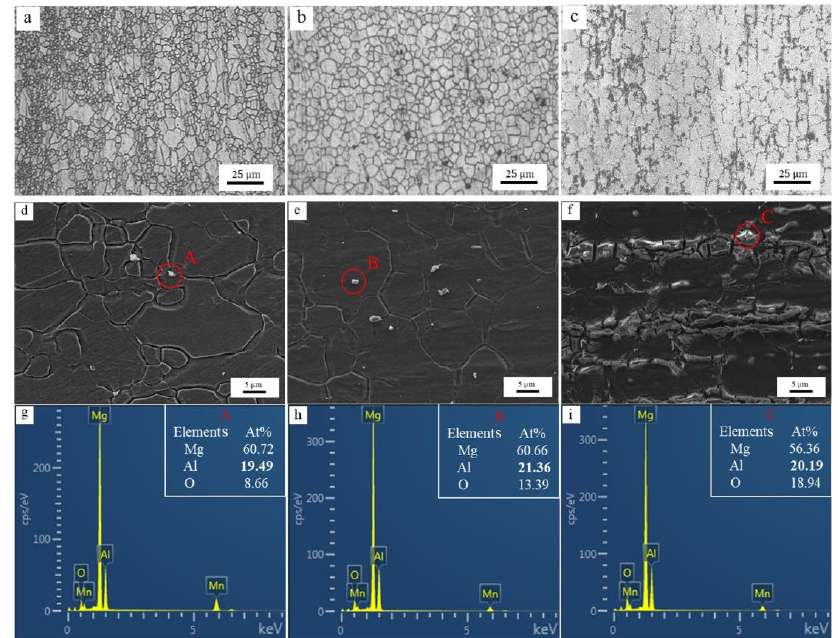
Figure 1. Optical micrographs and SEM images of extruded Mg alloys, corresponding to EDS of the second phase particles. ( a , d , g ) AZ31, ( b , e , h ) AZ61, and ( c , f , i ) AZ91.